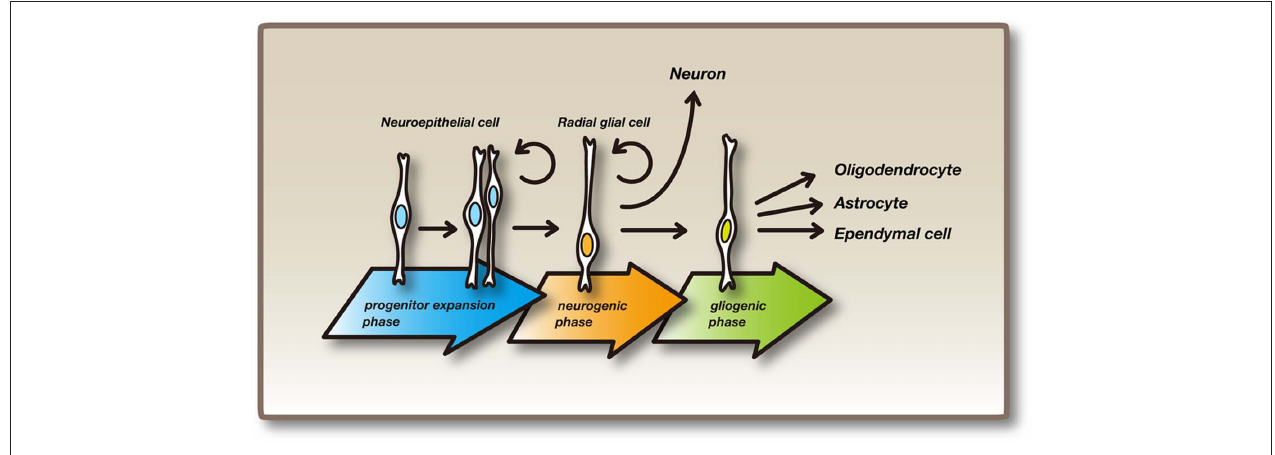
outer surface. Radial glial cells gives rise to neurons or basal progenitors (neurogenic phase). After the production of neurons, some radial glial cells give rise to oligodendrocytes and ependymal cells. Radial glial cells finally differentiate into astrocytes (gliogenic phase). Both neuroepithelial cells and radial glial cells are considered embryonic neural stem/progenitor cells.